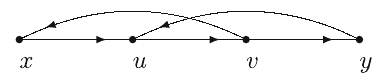
Figure 1: A quasi - transitive digraph QT 4